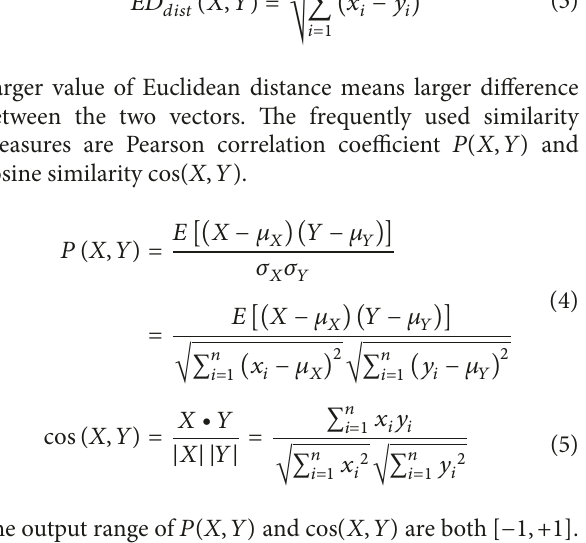
and 𝑉 𝐼 is the scene category feature vector of scene category 𝑖